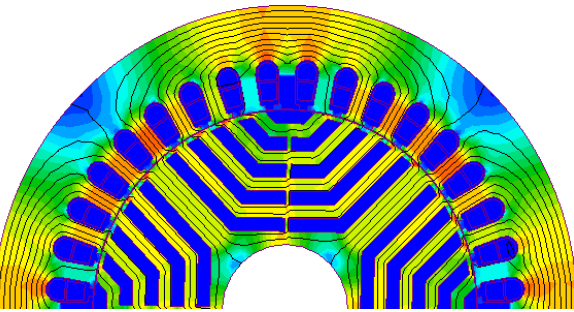
Figure 6. Magnetic flux and magnetic flux distribution in motor cross-section.